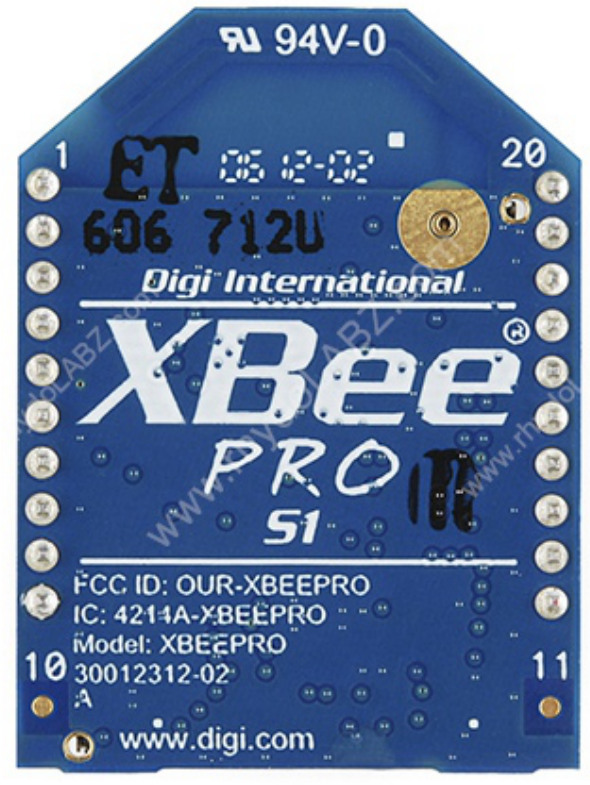
Figure 11. ZigBee